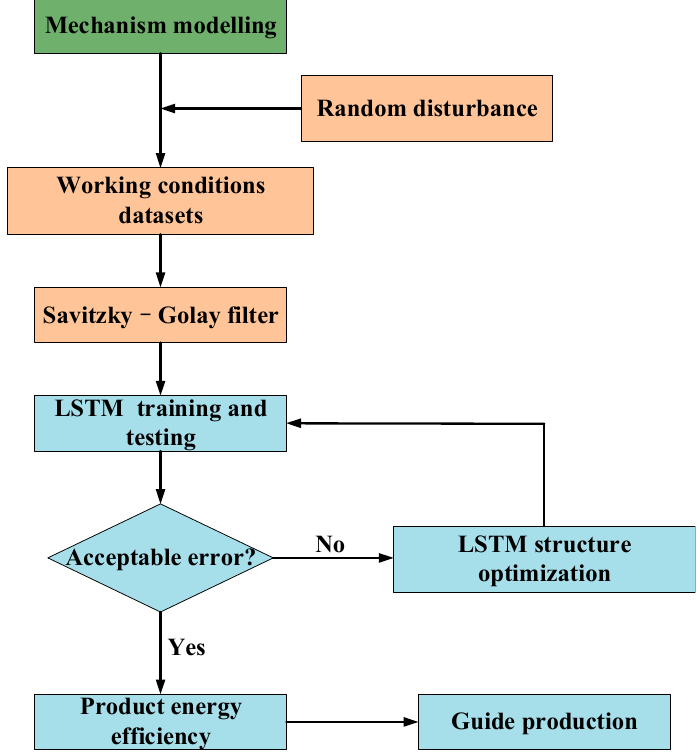
Figure 1. The framework of proposed method.